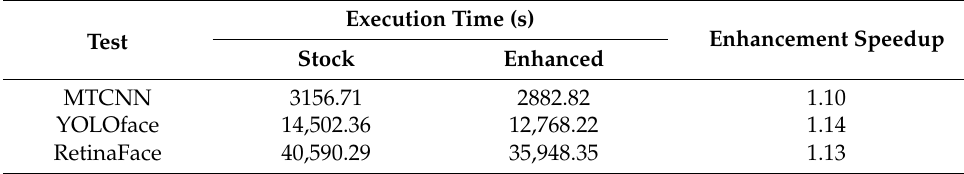
Table 6. Results for Experiment 2 using the enhancements for Pi 4B.